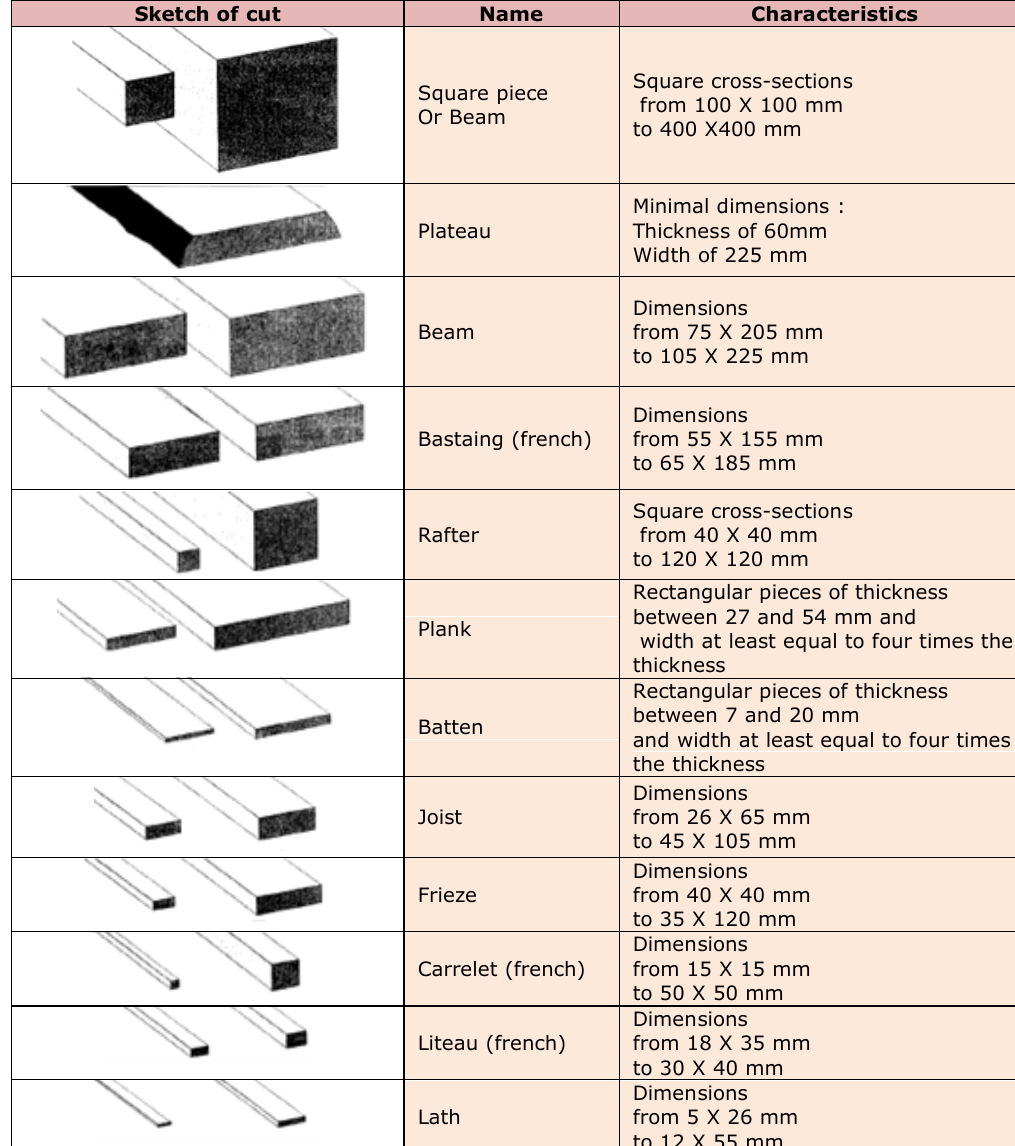
Table 1. products from the first stages of primary conversion of